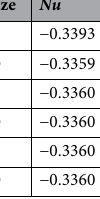
Table 4. Analysis of grid points for the Nusselt number as follows.